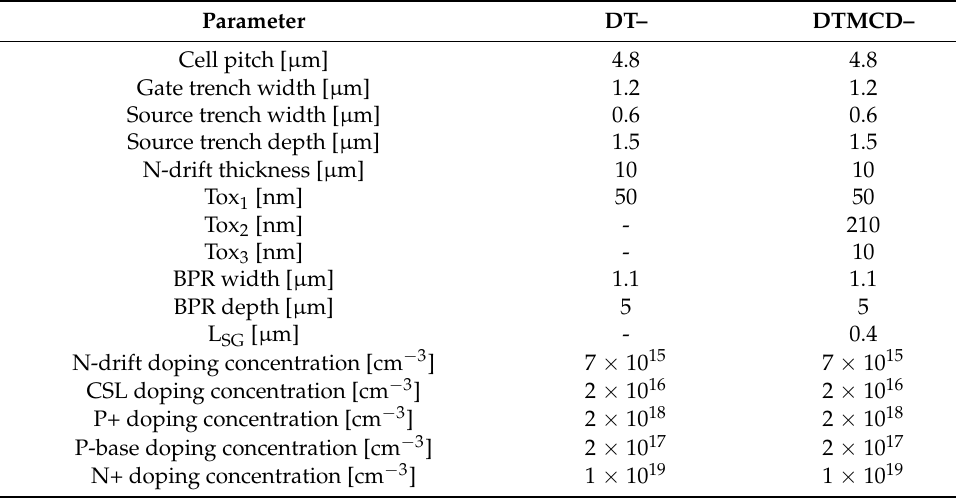
Figure 1. Cross-sectional view of ( a ) DT-MOSFET and ( b ) DTMCD-MOSFET. Table 1. Device parameters comparison.